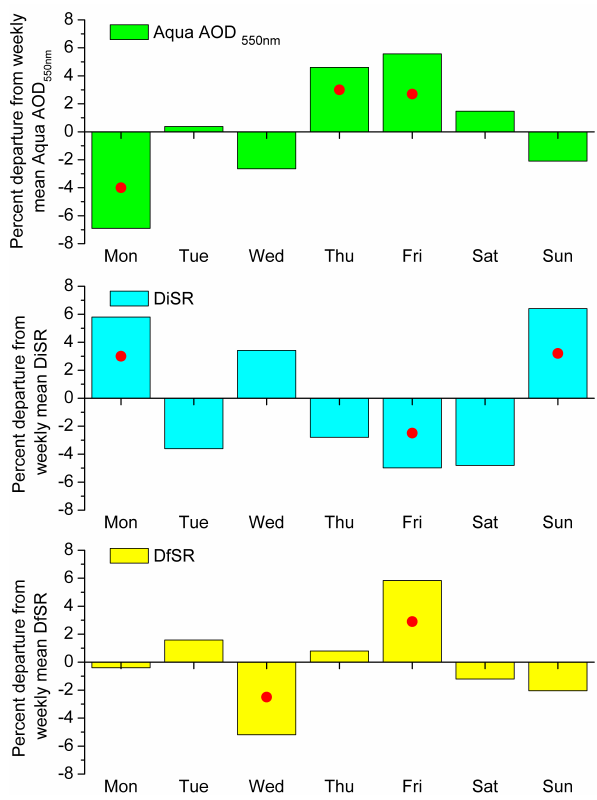
Fig. 8. Same as Fig. 7, but for the AOD data are from the MODIS Aqua products at 550nm. Aqua overpasses Shanghai